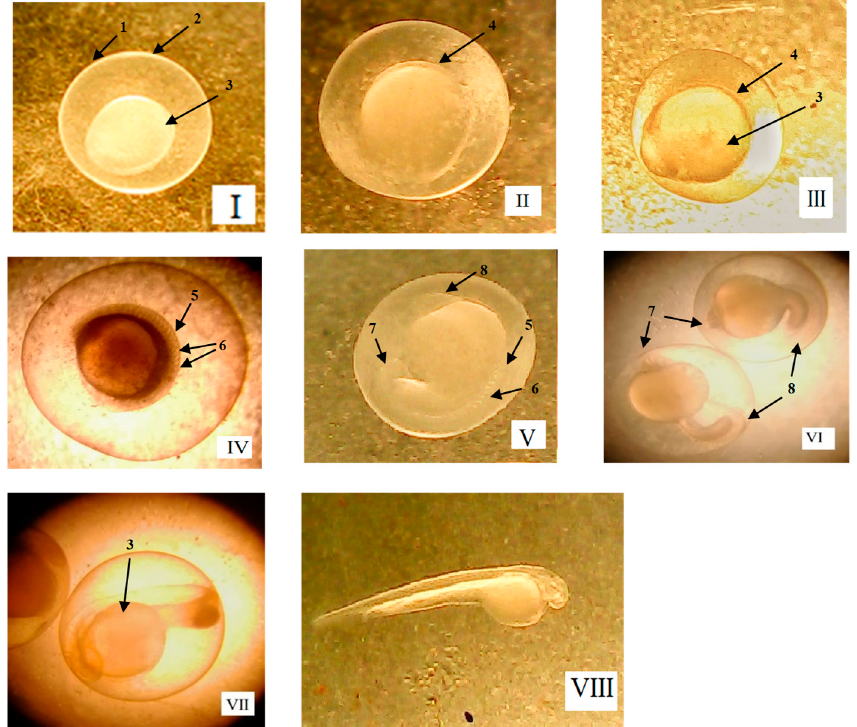
Figure 4. Stages of the embryonic period of the life cycle of the Balkhash marinka; stages I – III —activation of the egg and formation of the blastodisc; stage IV —gastrulation; stage V —organogenesis; stages VI – VII —separation of the tail section from the yolk sac; stage VIII —postembryo of the Balkhash marinka and development of the gill–jaw apparatus. Arrows: 1—caviar shell; 2—perivitelline space; 3—yolk sac; 4—blastodisc; 5—neural tube; 6—somites; 7—the head section of the embryo; 8—tail section of the